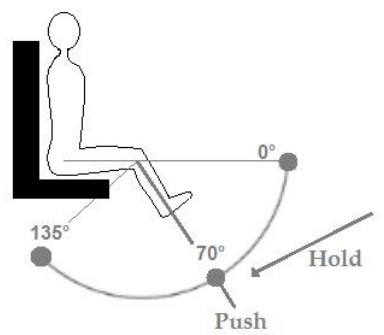
Figure 1. Illustration of force application of the isokinetic dynamometer in the push and hold isometric task.